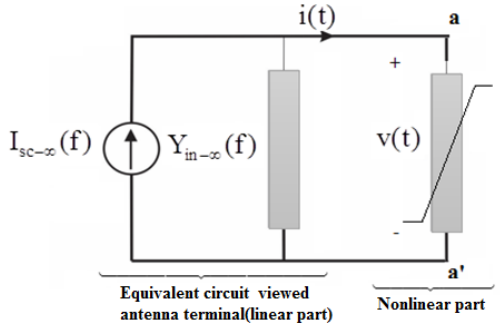
FIGURE 2. Equivalent circuit of different infinite arrays of nonlinear antennas consisting of linear and nonlinear